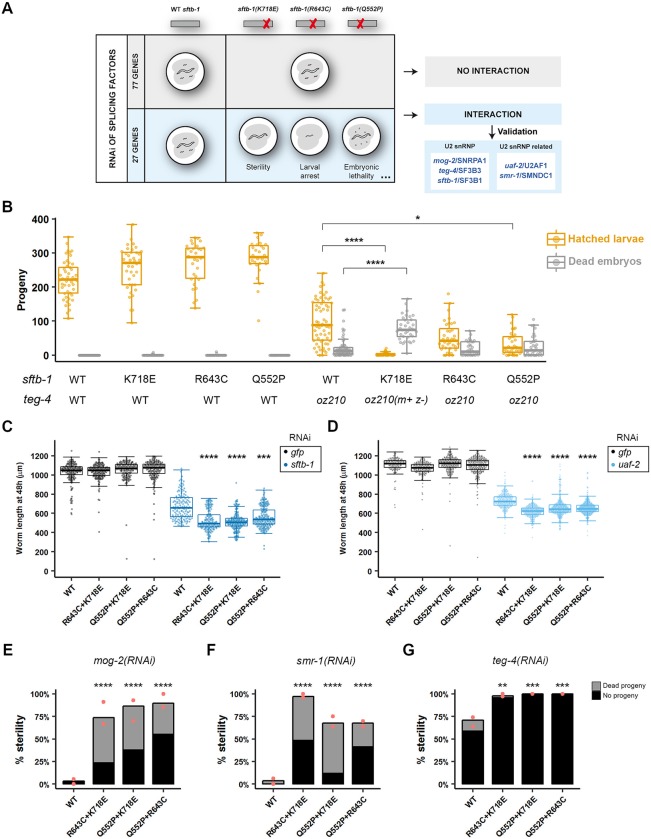
Synthetic interaction between sftb-1 mutant strains and knockdown of U2 snRNP and U2 snRNP-related components.(A) Schematics of the RNAi screen. In brief, WT or mutant worms bearing any of the three sftb-1 single mutations were fed with RNAi clones against a total of 104 splicing factors. 77 clones had the same effect in all genetic backgrounds. In contrast, we identified 27 clones that caused a stronger phenotype in at least one of the three single mutant strains compared to WT, which was indicative of a synthetic interaction. Listed are the 3 U2 snRNP and 2 U2 snRNP-related candidates from the screen that were selected for further validation. (B) sftb-1[K718E] and sftb-1[Q552P] synthetically interact with teg-4(oz210). The number of hatched larvae (orange) and dead embryos (gray) laid by worms of the indicated genotype at 20°C is represented (n≥28; N = 3). m+ z-, homozygous mutant progeny of heterozygous mothers. No significant differences were observed in the number of hatched larvae laid by sftb-1[K718E], sftb-1[R643C], and sftb-1[Q552P] compared to WT. (C) Worm length after 48 h of RNAi treatment against gfp (black) or sftb-1 (blue) at 25°C (n≥150; N = 2). (D) Worm length after 48 h of RNAi treatment against gfp (black) or uaf-2 (blue) at 25°C (n≥150; N = 2). In both (C) and (D), worm length was not significantly different between sftb-1 mutants and WT upon gfp(RNAi). (E-G) Mean percentage of sterile worms observed upon RNAi of mog-2 (E; n≥30), smr-1 (F; n≥27) and teg-4 (G; n≥34) at 25°C. Red dots indicate percent sterility observed in each replicate (N = 2). Gray bars, P0-treated worms giving rise to <5 F1 larvae and some dead embryos (‘dead progeny’ category); black bars, P0-treated worms that laid neither larvae nor dead embryos (‘no progeny’ category). In (B), (C), and (D), data are shown as Tukey-style boxplots and overlaid dots representing measures in individual animals. Statistics: (B), (C), and (D), Kruskal-Wallis test with Dunn’s multiple comparison test. Data were compared to teg-4(oz210) (B), or to WT animals fed with the same RNAi clone (C) and (D). (E-G), Fisher’s exact test with Bonferroni correction for multiple comparison. * p<0.05, ** p<0.01, *** p<0.001, **** p<0.0001.